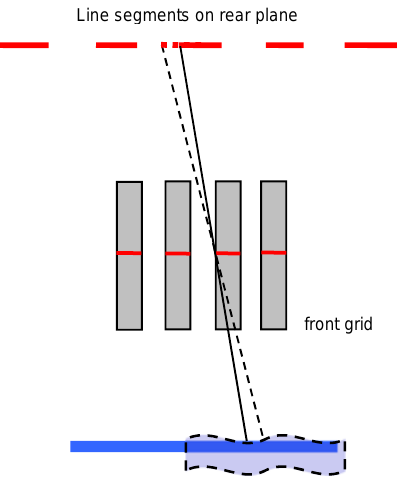
Figure 9: shifts on rear plane induced by lateral